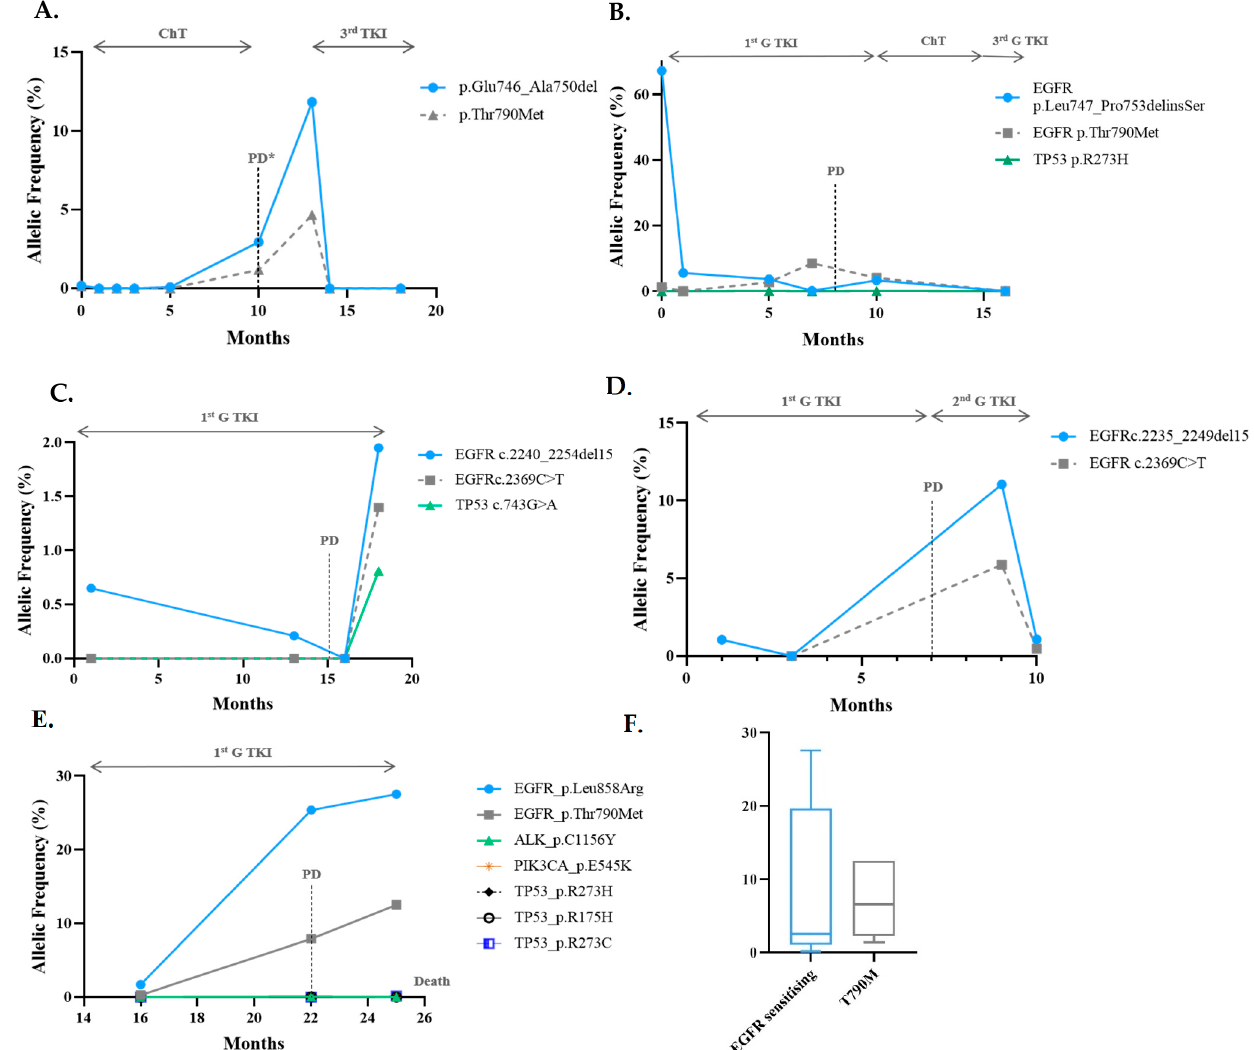
Figure 3. Progression with T790M in EGFR patients. ( A – E ), serial monitoring of cfDNA in five patients that developed T790M mutation as resistance mechanism to 1st/2nd G TKIS. The emergence and rise of the T790M (grey line) were accompanied by an increase in the original sensitising mutation (blue line), except for ( B ). In ( B ), dual Del19 and T790M were detected at diagnosis, and when progression occurred, there was a rise of the T790M clone, with a clearance of both clones when 3rd generation TKI was initiated. In ( E ), cfDNA analysis also revealed residual amounts of pathogenic TP53 mutations, ALK C1156Y and PIK3CA E545K, not detected initially. ( F ) Comparison of the VAF ctDNA of the EGFR sensitising mutation and the T790M at progression. The black arrow on the top of the graph indicates the treatment administrated during that time. ChT, chemotherapy; TKI, Tyrosine Kinase Inhibitor; PD, Progressive Disease; PR, Partial Re- sponse.